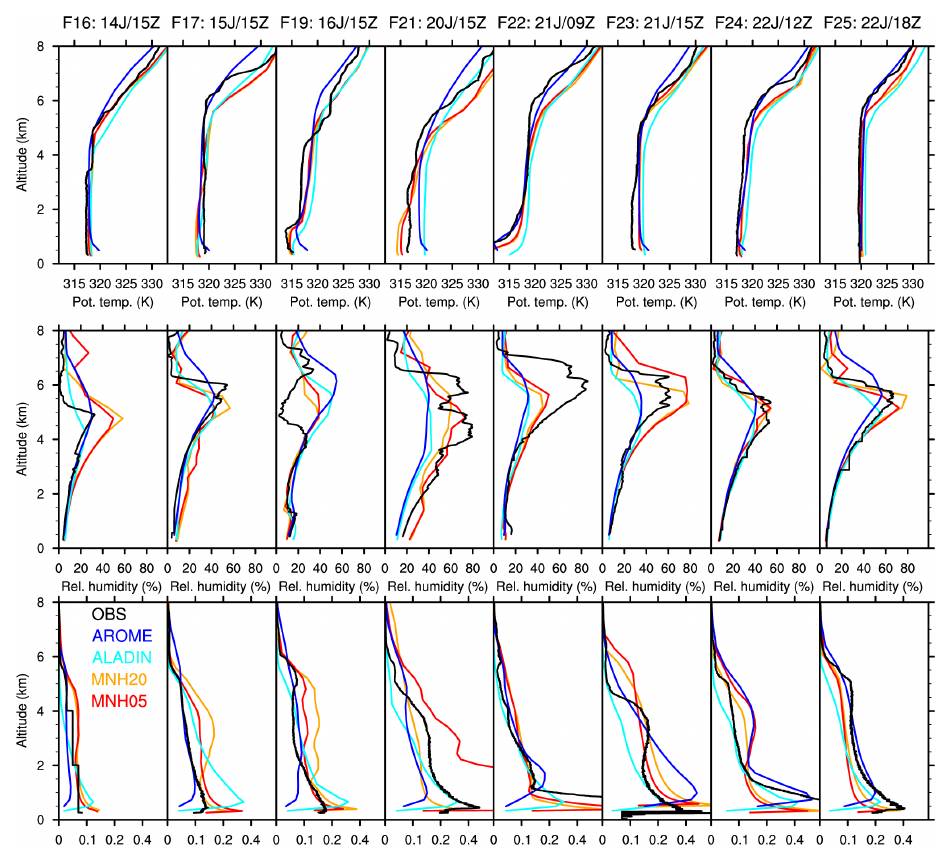
Figure 10. Profiles of (top) potential temperature, (middle) relative humidity and (bottom) dust extinction for the selected legs of the Falcon flights F16, F17, F19, F21, F22, F23, F24 and F25. The locations of the legs are shown in Fig.